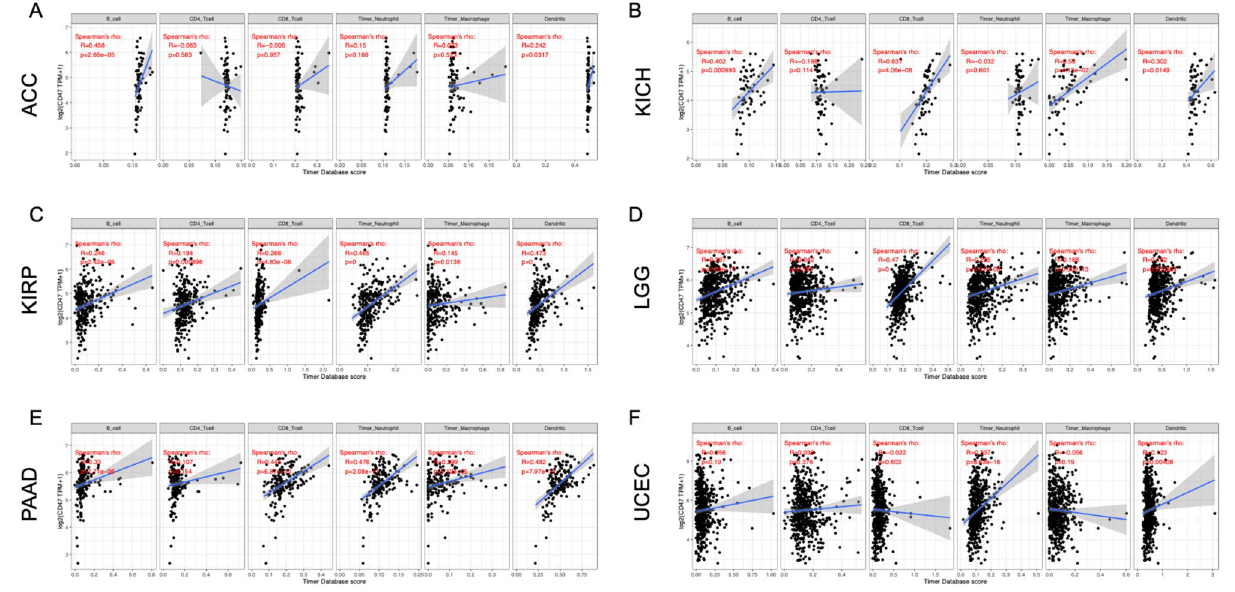
Figure 3. The relationship between CD47 expression and immune infiltrating level in ACC, KICH, KIRP, LGG, PAAD, UCEC ( A – F ). The expression of CD47 is positively related to the tumor infiltrating cells such as CD4+ T cells, CD8+ T cells, B cell, neutrophil, dendritic cells and macrophages in various types of cancer.